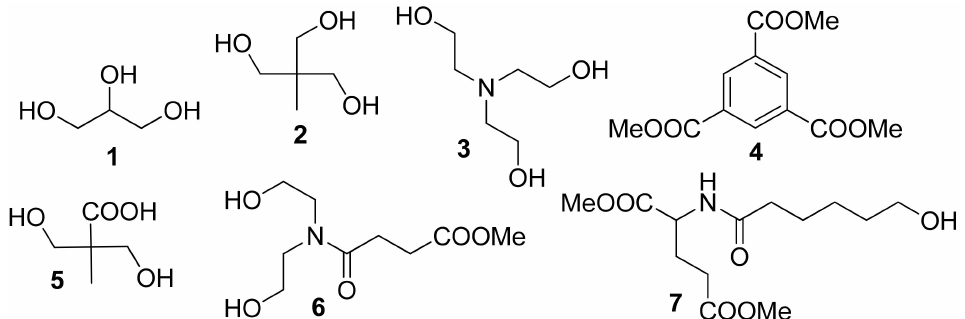
Figure 2. Branching agents 1 – 7 studied in this